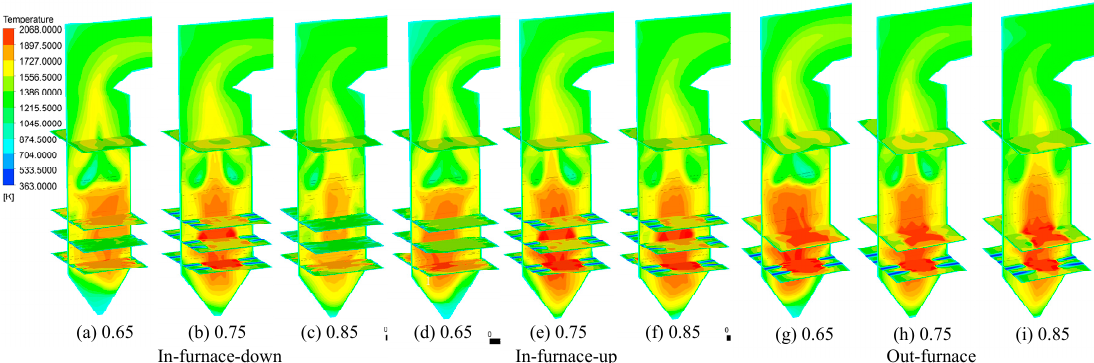
Figure 10. The temperature contours within furnace at various α 1.